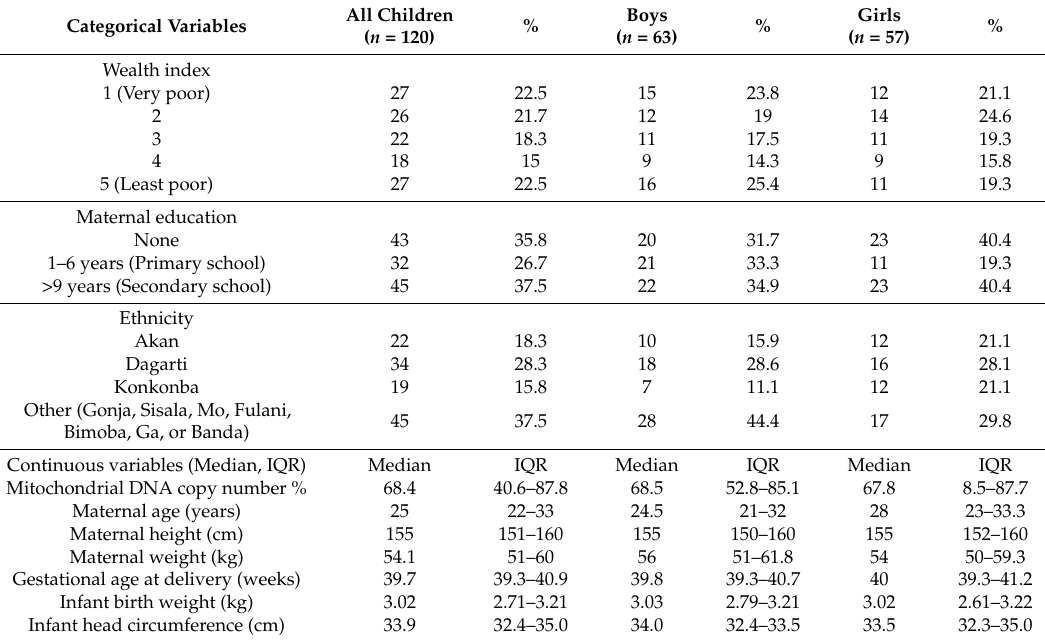
Table 1. Participant characteristics.